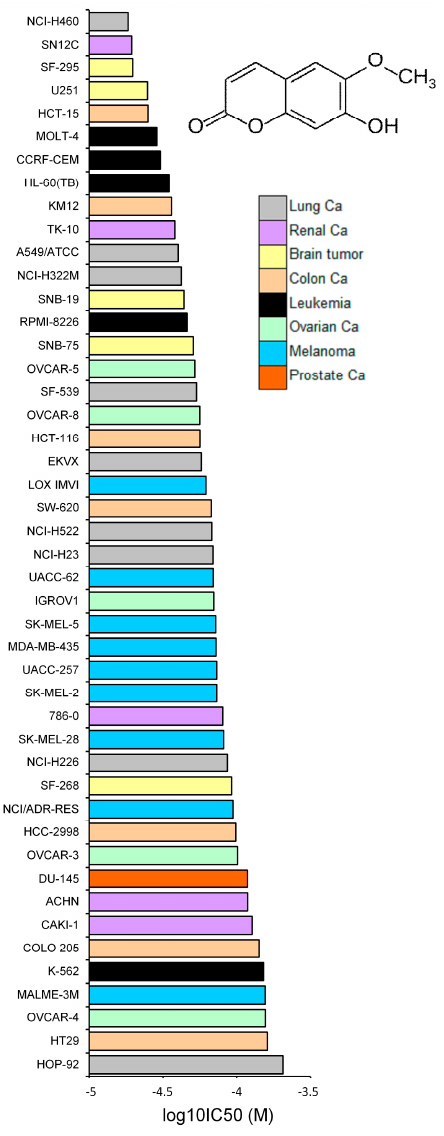
Figure 3. Chemical structure of scopoletin and mean values and standard deviations of log 10 IC 50 values for scopoletin of NCI cell lines of different tumor types.